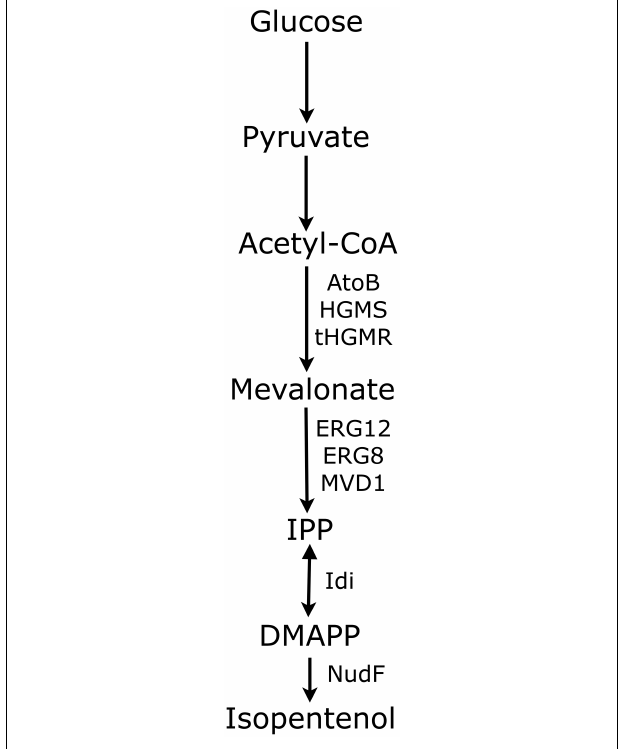
FIGURE 3 | Metabolic representation of mevalonate isoprenoid pathway for biofuel production. AtoB, acetyl-CoA thiolase; HGMS, HMG-CoA synthase; tHGMR, truncated HMG-CoA reductase; ERG12, mevalonate kinase; ERG8, phosphomevalonate kinase; IPP, isopentenyl diphosphate; Idi, IPP isomerase; DMAP, dimethylallyl diphosphate; NudF, ADP-ribose